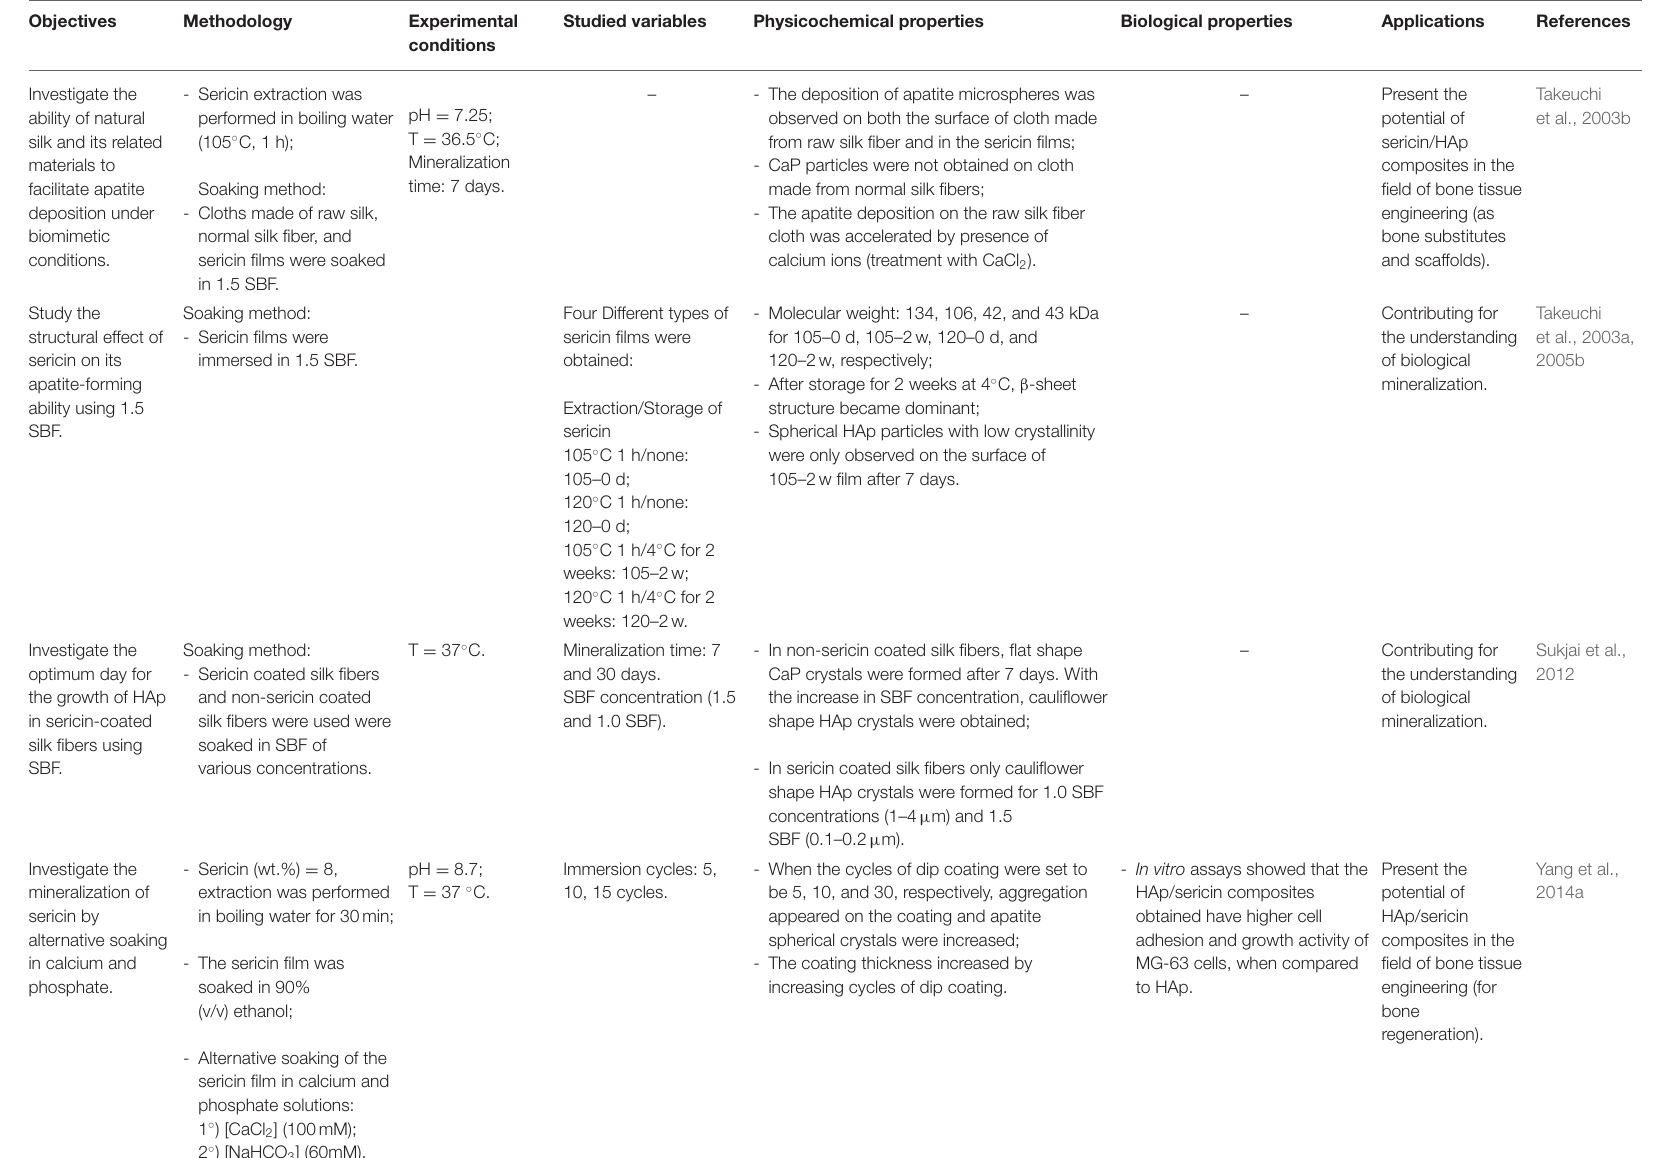
TABLE 1 | Articles on sericin/CaP